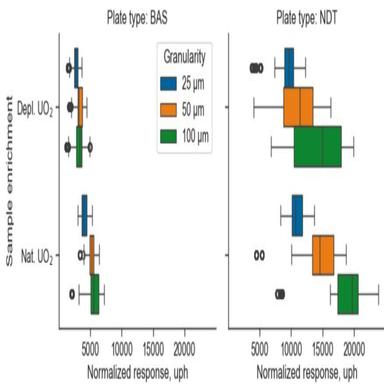
Normalized signal response (uph = units per hour) for different U isotopic compositions, readout granularities and IP types. The plot on the left showcases data obtained from a BAS imaging plate, while the plot on the right features results from an NDT plate. To facilitate a direct comparison between the two IP types, the normalized response axis range has been kept constant. The three distinct data series correspond to different readout granularities.